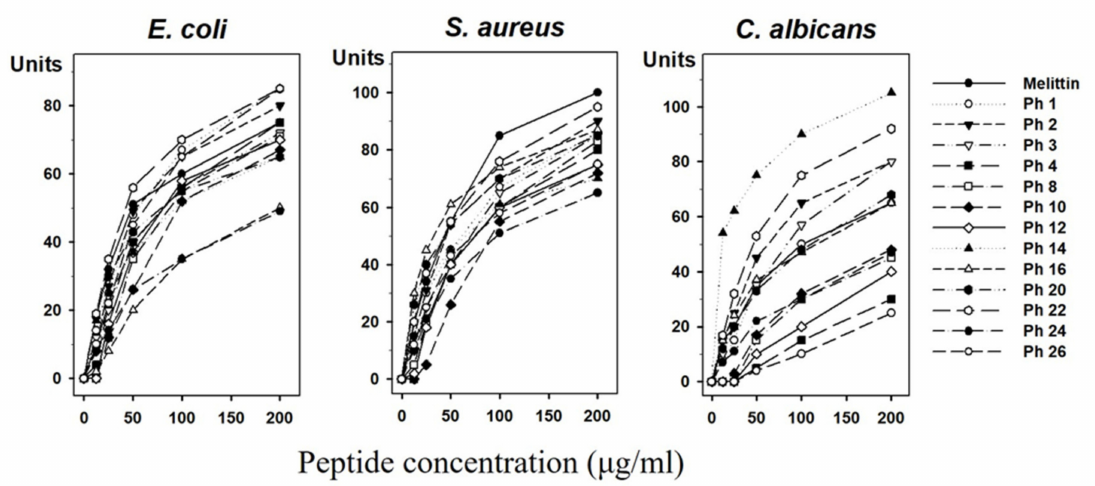
Figure 3. Antimicrobial activity assay. Antimicrobial activities of 13 selected peptides against E. coli , S. aureus , and C. albicans determined by a radial di ff usion assay. Peptide concentration ( x -axis) was plotted against the diameter of the microbial growth inhibition zone ( y -axis) after incubation for 12 h and is expressed in units (1 mm = 10 units). Melittin was used as a positive control. Mean values were obtained from tests repeated three